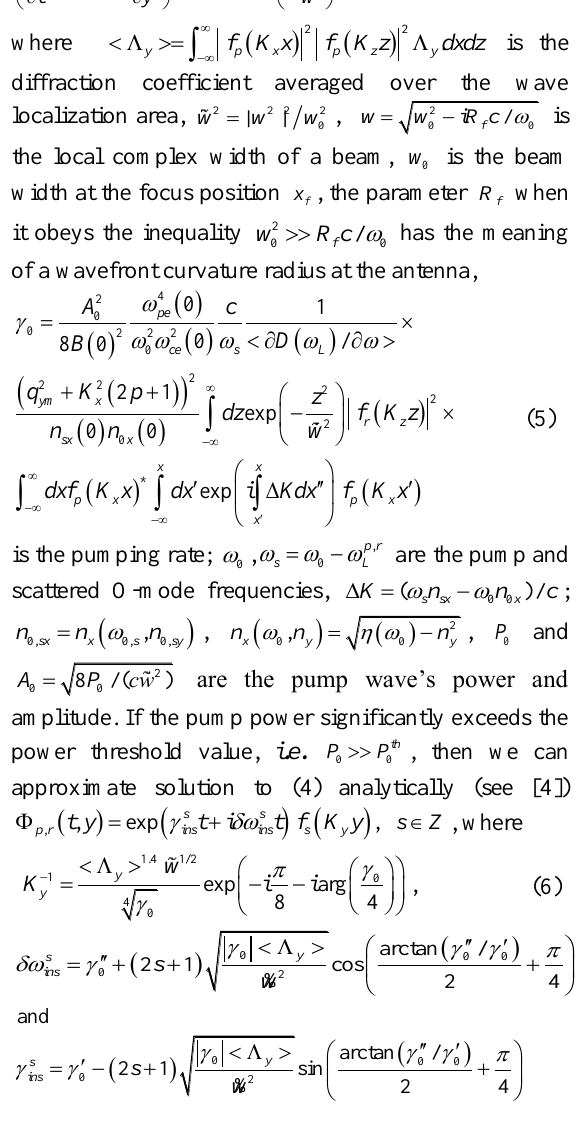
p r p r p r r K    L L z L p r p r p r Q q q p K L L y y x L